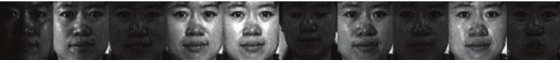
Figure 2: Sample face images from the CMU PIE